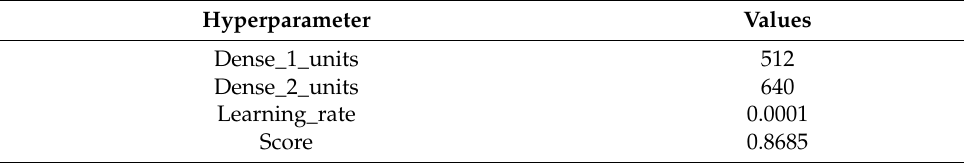
Table 5. Summary of MLP model hyperparameter search result (Best